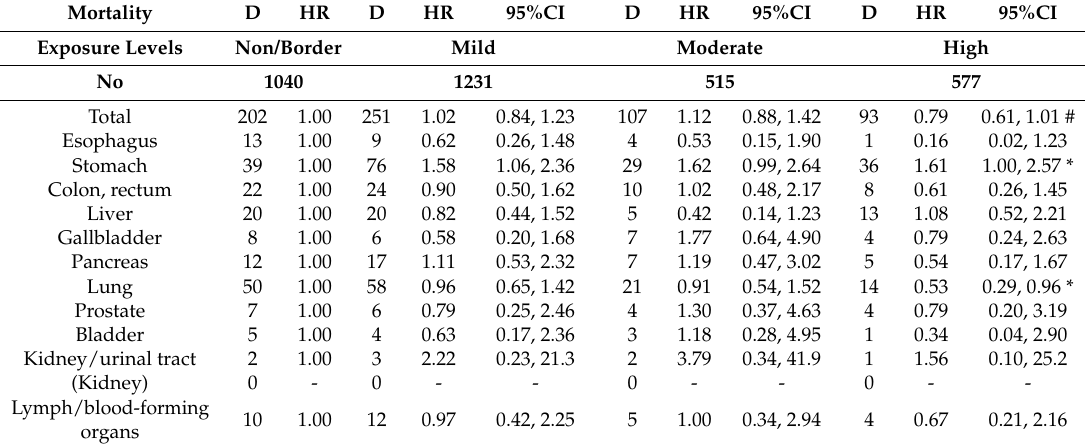
Table 5. Mortality risk ratios for cancer in three exposed male groups compared with men living in the areas with borderline exposure in the Cd-exposed Jinzu River basin. Mortality Exposure Levels